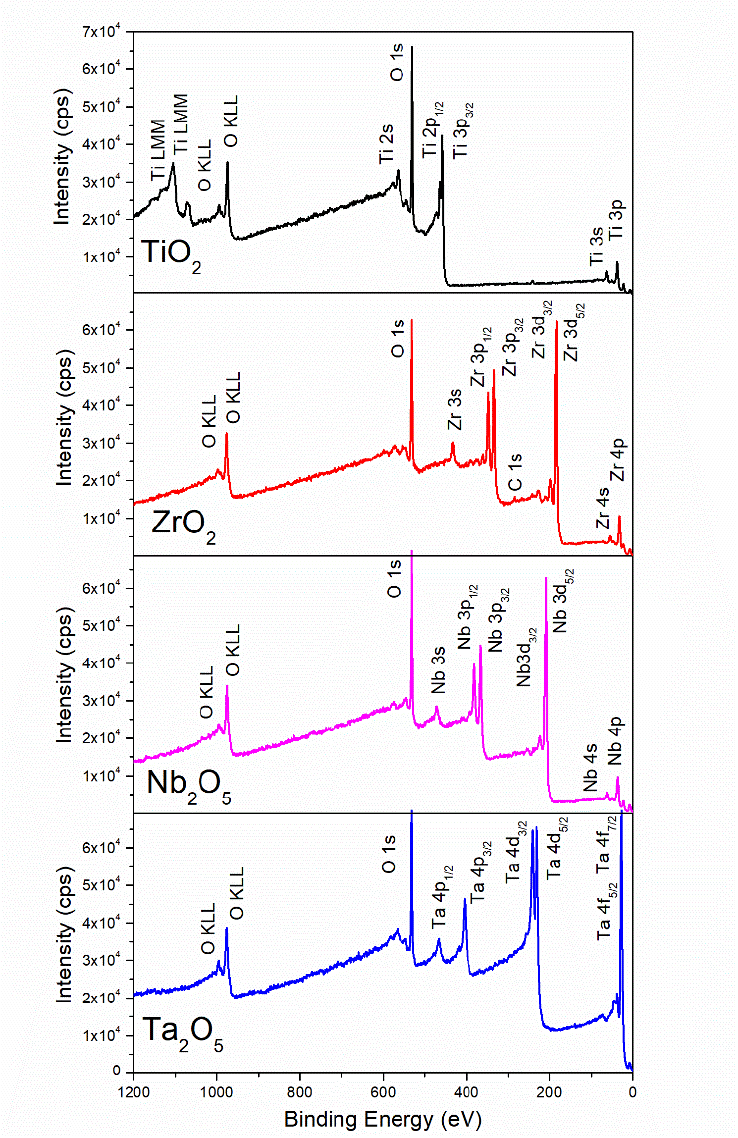
Figure 3. Example low resolution XPS spectra of TiO X (TiO 2 ), ZrO X (ZrO 2 ), NbO X (Nb 2 O 5 ) and TaO X (Ta 2 O 5 ).